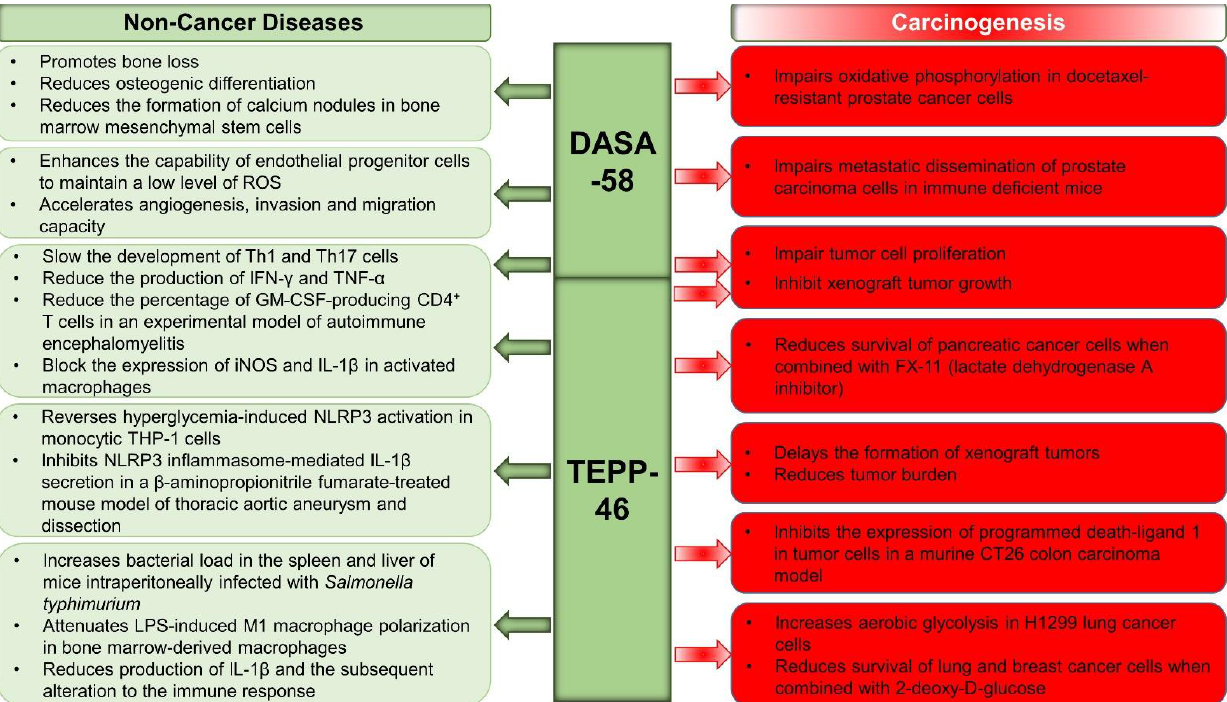
Figure 2. Some potential effects of PKM2 activation by DASA-58 and TEPP-46 in cancer and non-cancer diseases. Consistent with these findings, TEPP-mediated activation of PKM2 in a murine solid CT26 tumor model reduced the ability of macrophages, dendritic cells, T cells, and tumor cells to express programmed death-1 (PD-1) ligand 1 (PD-L1) [179] ( Figure 2 ). Acting as a signaling gatekeeper, PD-L1 plays a key role in the development of immune tolerance to prevent excessive response [180], but also in blocking the development of the T cell re- sponse against tumor cells ([179]. In the same line of thought, treatment of resting CD4 + CD62L + T cells with TEPP halted their proliferation and activation. Additionally, in vitro